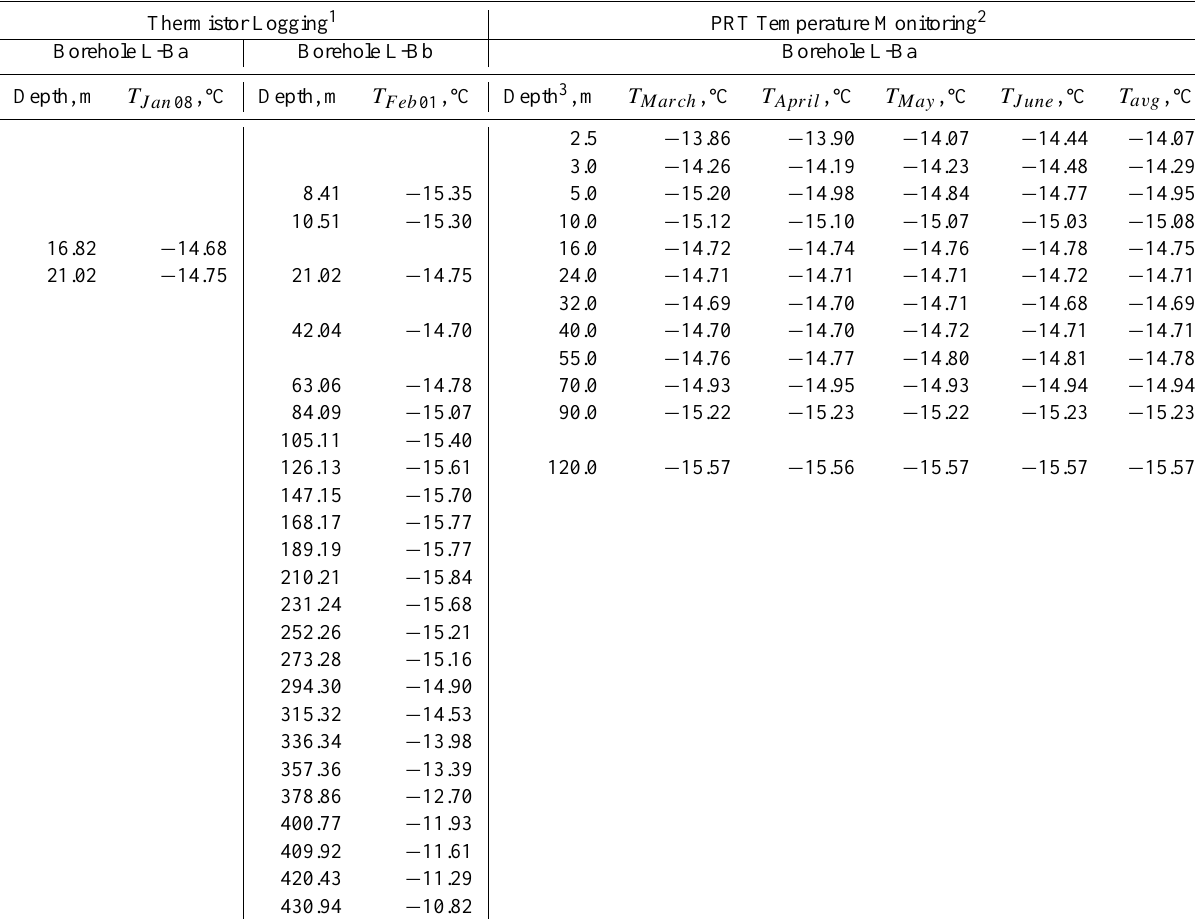
Table 2. Borehole Temperature measurements at LARISSA Site Beta, Bruce Plateau. Thermistor Logging